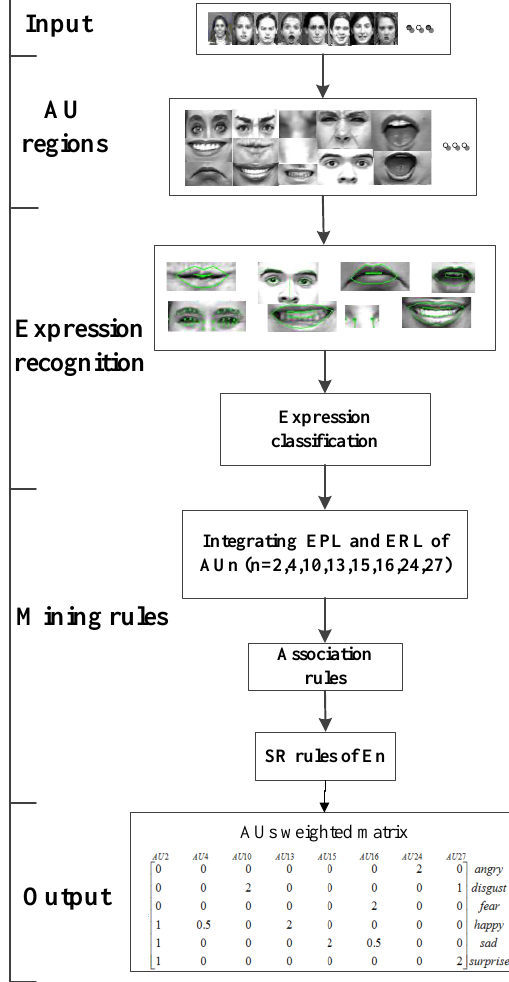
Figure 6. The framework of the a priori based strong relationship mining between AU and emotion.